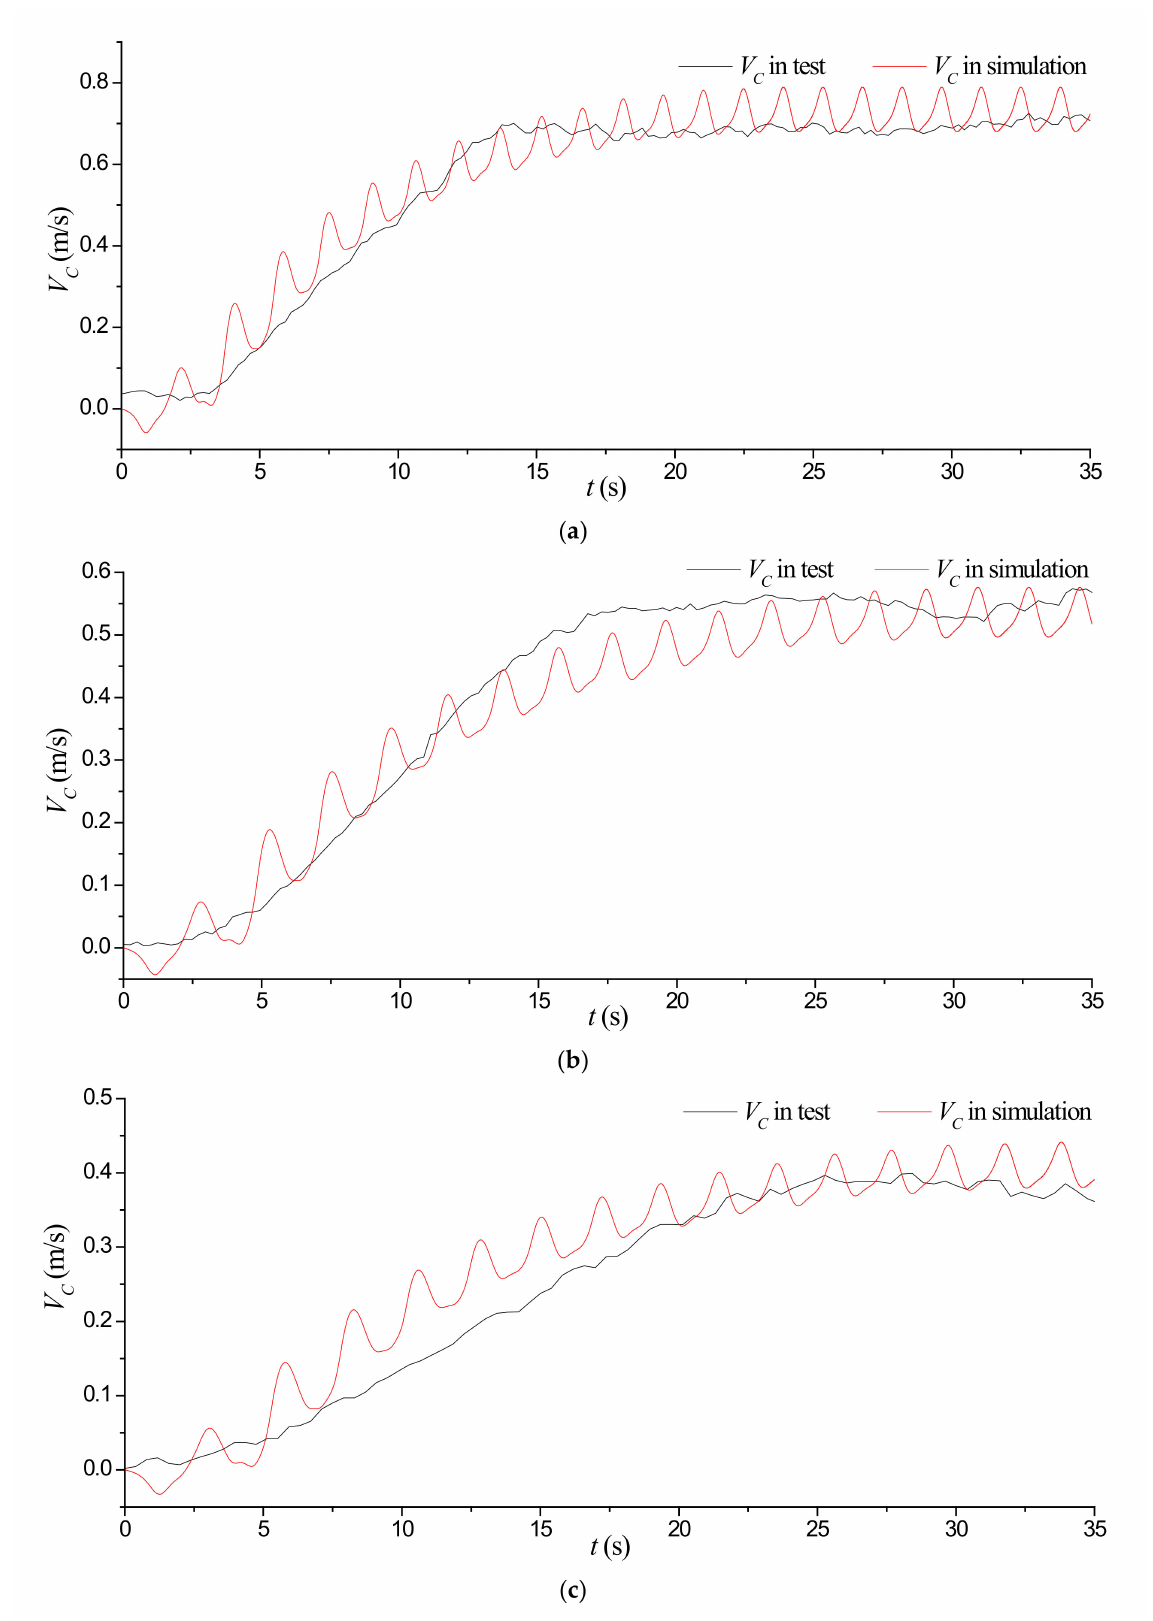
Figure 16. Comparison between V C in test and that in simulation when the wave height is 0.25 m. ( a ) Comparison of V C under wavelength of 6 m when the wave height is 0.25 m. ( b ) Comparison of V C under wavelength of 10 m when the wave height is 0.25 m. ( c ) Comparison of V C under wavelength of 12 m when the wave height is 0.25